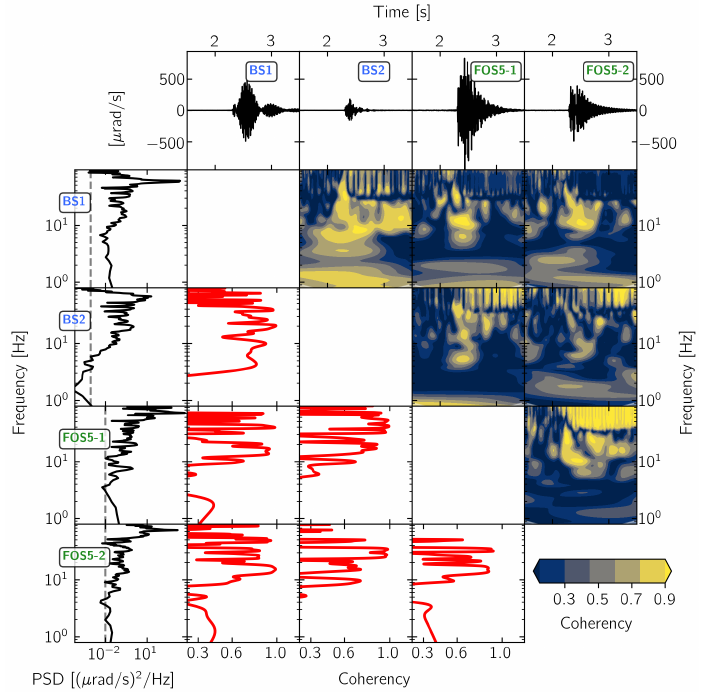
Figure 6. Waveform coherency for pairs of 1C vertical rotation rate sensors. The vertical component recording from explosion “expl2” on 19 November 2019 at 15:16:45 UTC (see Figure 1) is shown. For more details see Figure 5.